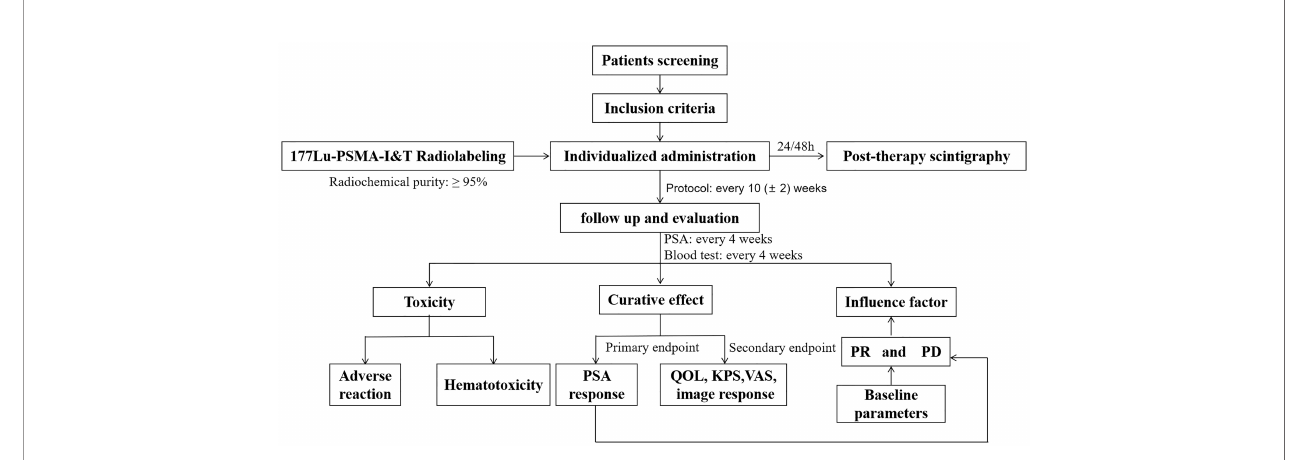
FIGURE 1 | Flow chart of clinical